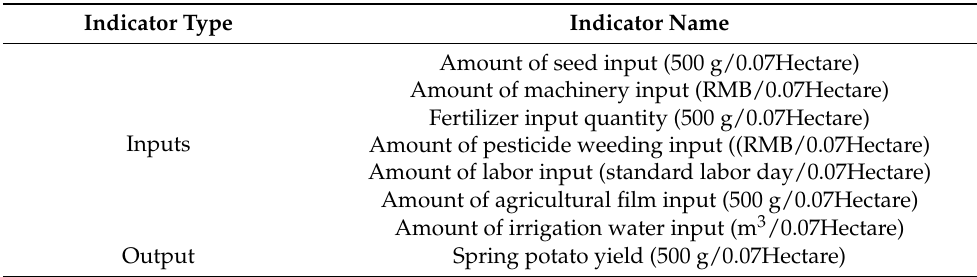
Table 2. Input-output indicator system for measuring irrigation efficiency of farmers’ largest plots for spring potato